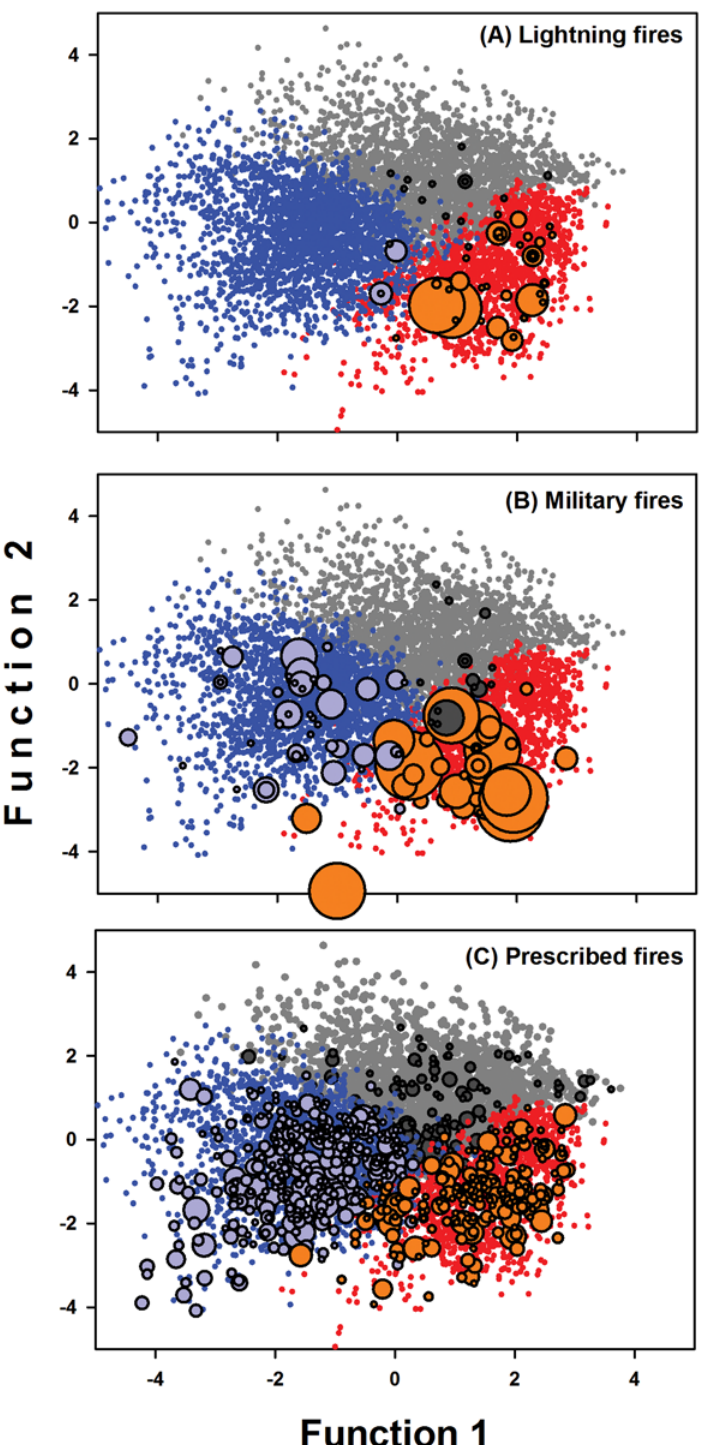
Figure 4. Relationships between the size of fires and climate as described on the fire-weather plane. Fire size is shown with bubble plots, with the size of bubbles being proportional to the size of fires. Shown are (A) lightning fires (n = 59), (B) military fires (n = 112), and (C) prescribed burns (n = 664). The seasons of the selected model are shown with different colored dots (wet season, gray dots; dry season, blue dots; peak fire season, red dots). Bubbles detailing fire size are filled with colors related to the season in which they